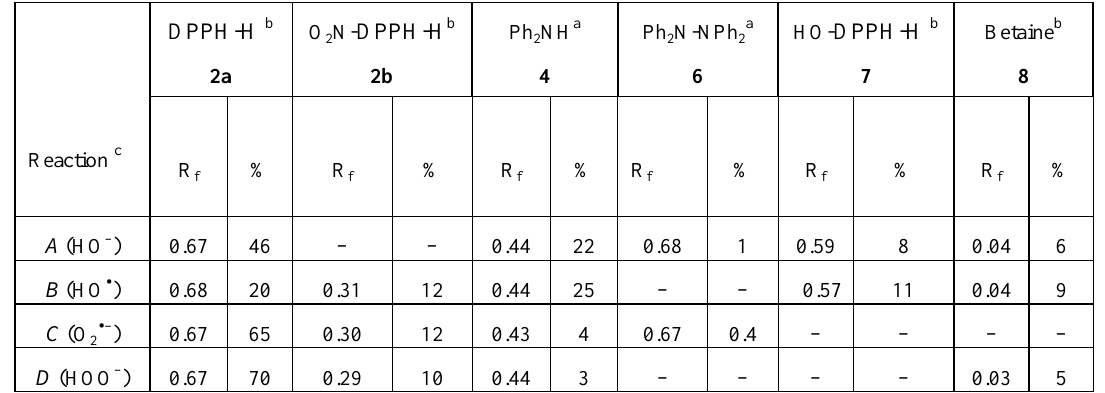
benzene after 24